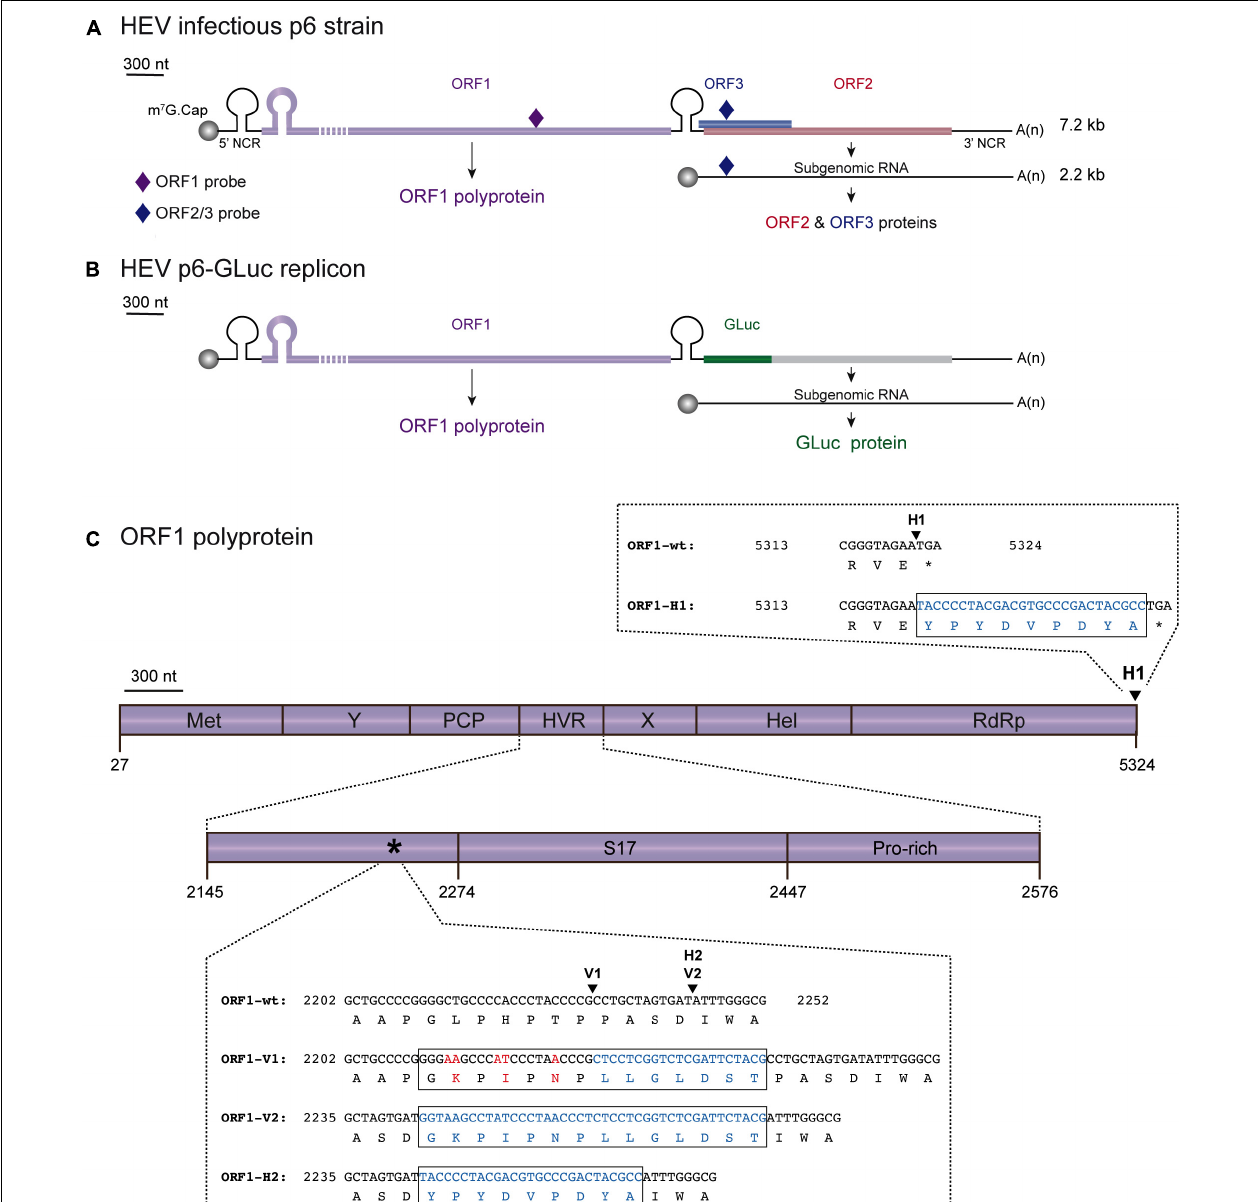
FIGURE 1 | Localization scheme of epitope tag insertions within the ORF1 polyprotein of HEV. (A) Scheme of the HEV Kernow C-1 p6 (GenBank accession number JQ679013) genome and encoded proteins. The full-length HEV genome (7.2 kb) is composed of 5 (cid:48) and 3 (cid:48) non coding regions (NCR) as well as three open reading frames: ORF1 (purple) encoding the HEV replicase, ORF2 (red) and ORF3 (blue) encoding the capsid and a small phosphoprotein, respectively. The HEV subgenomic RNA of 2.2 kb is depicted as a thin black line. The probes used in RT-qPCR experiments are located as small colored rhombus: ORF1-specific probe (dark purple) and ORF2/ORF3-specific probe (dark blue). The full-length of the ORF1 protein cannot be represented at the scheme scale (purple dashed lines). (B) Scheme of the HEV p6-GLuc replicon genome and encoded proteins. The Gaussia luciferase (GLuc, green) replaces the ORF3 and the N-terminus of ORF2 in the HEV p6-GLuc replicon. (C) The ORF1 is enlarged and its functional domains are designated as methyltransferase (MeT), Y domain (Y), papain-like cysteine protease (PCP), hypervariable region (HVR), macro- or X-domain (X), helicase (Hel), RNA-dependent RNA polymerase (RdRp). Insertion position of an HA epitope at the C-terminus of ORF1 is localized (H1, arrowhead). C-terminal nucleotide and aa sequences of RdRp are detailed for the ORF1 untagged wildtype (ORF1-wt) and HA-tagged (ORF1-H1) proteins with inserted epitope sequence highlighted in blue (box). A focus on the HVR enables to locate the human S17 ribosomal protein insertion (S17) of the HEV Kernow C-1 p6 strain and the prolin-rich region (Pro-rich). An asterisk points at the 2,202–2,252 region whose nucleotide and aa sequences are detailed (box). Two other sites of insertion of V5 or HA epitopes are shown (arrowheads): V1 and V2 for V5 epitope insertions and H2 for HA epitope insertion. Part of the HVR sequences of the wild-type (ORF1-wt) as well as the epitope-tagged ORF1 are presented (ORF1-V1, ORF1-V2, ORF1-H2). Mutated nucleotides and aa residues are in red. Inserted nucleotides and aa residues are in blue.